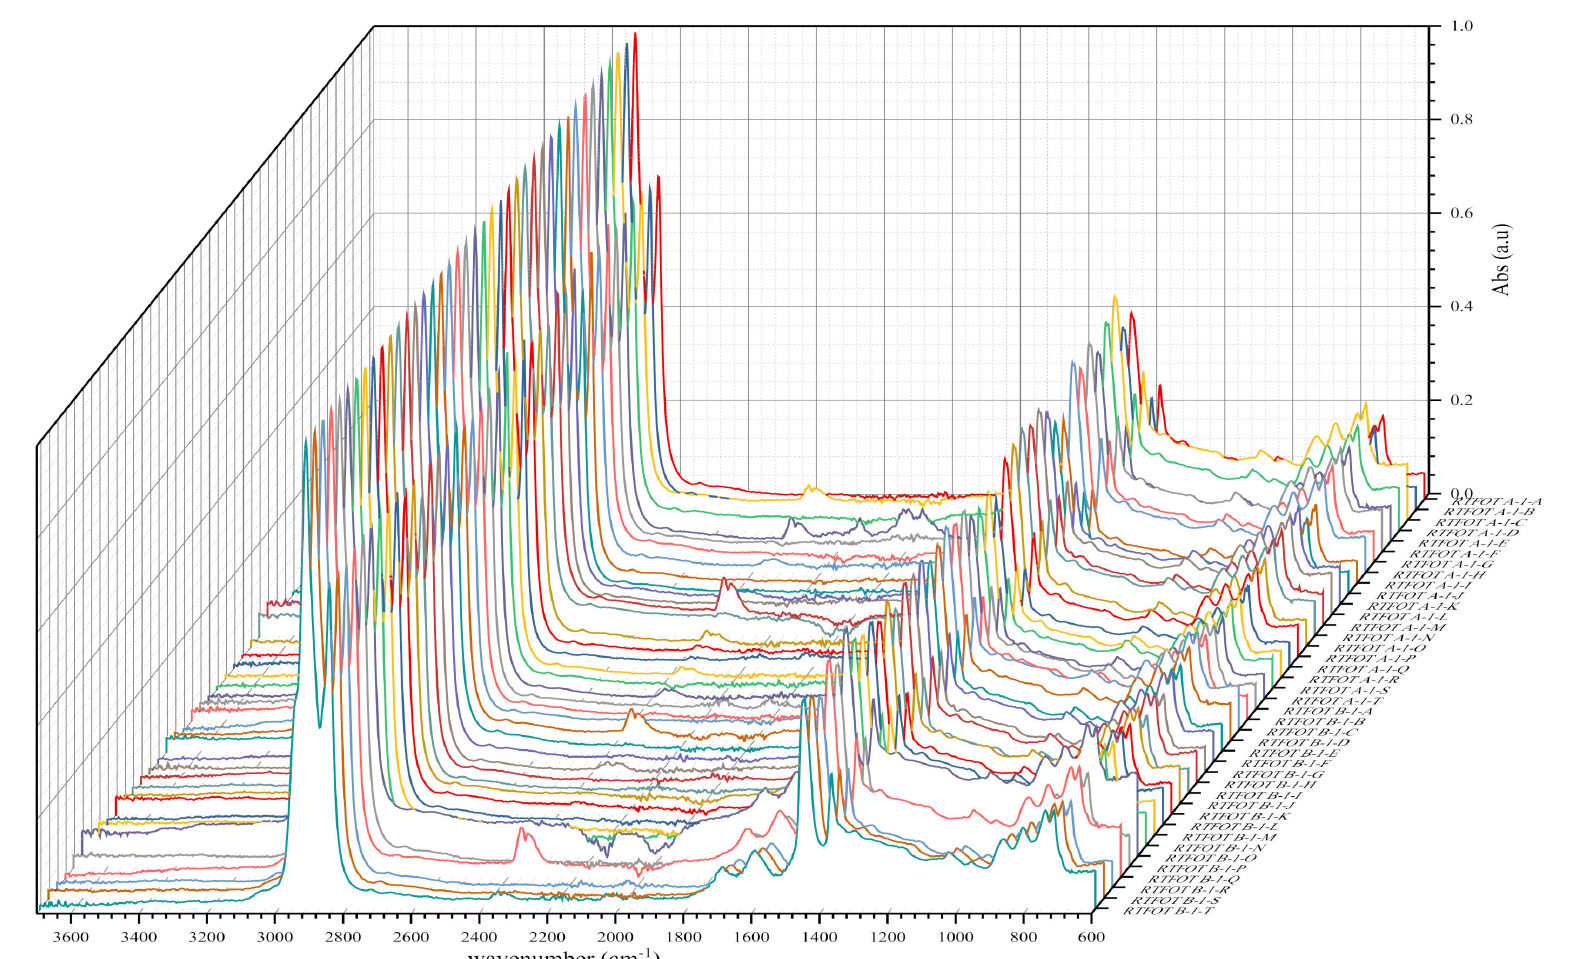
Figure 5. IR spectra of BND 70/100 from plants A and B after short-term ageing